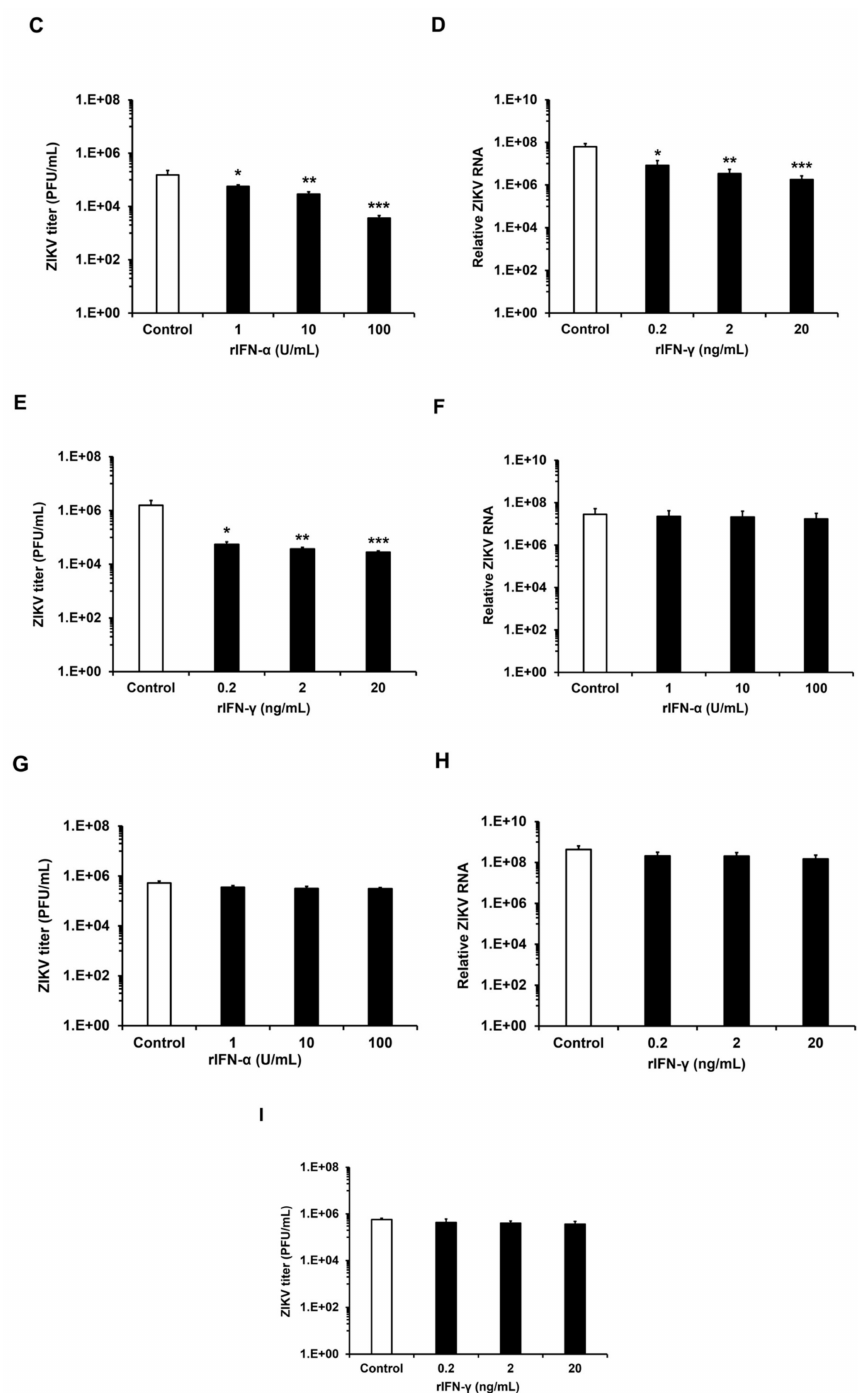
Figure 3. ( A ) Human recombinant IFN treatment and innate immune gene activation in persistently infected HFAs. Relative levels of IFIT1 and OAS transcripts (compared to actin mRNA) in chronically infected HFAs were determined by qRT-PCR. The average values obtained from two experiments using two independent donors are shown. ( B – E ) HFAs were treated before (12 and 0 h) or ( F – I ) after (24 and 48 h) ZIKV infection (MOI = 0.3) with the indicated amounts of IFN- α and γ . Two days later, supernatants and cell lysates were collected for viral determination by plaque assays ( C , E , G , I ) and viral genome quantitation by qRT-PCR ( B , D , F , H ) respectively. The average values obtained from three experiments using three independent donors are shown. Error bars represent standard error of the mean. * p < 0.05, ** p < 0.01, *** p < 0.001 (Student’s t